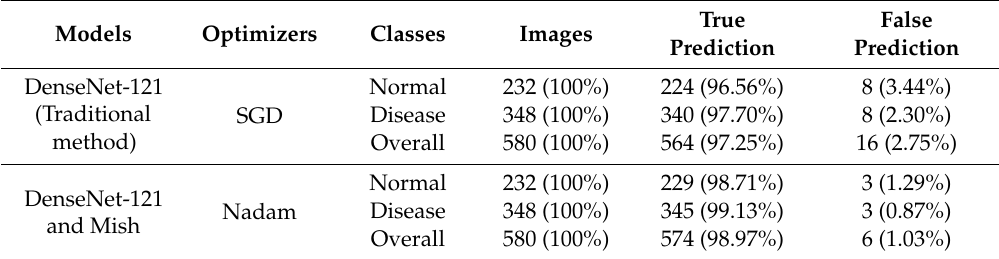
Table 6. Comparative performance of model testing using DenseNet-121 combined with Mish and Nadam and the traditional method of